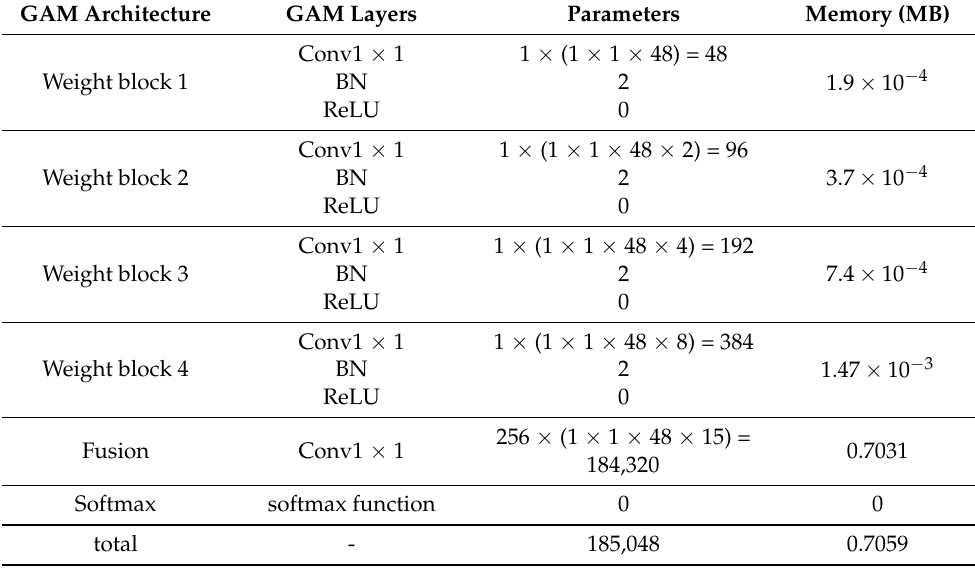
Table 6. Statistical results of the GAM